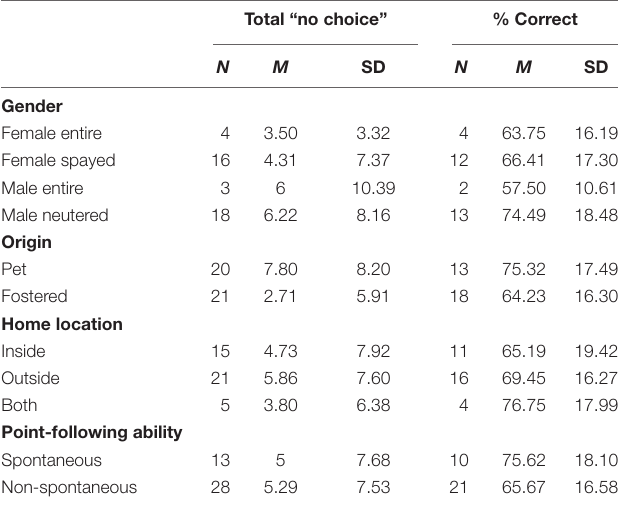
N = sample size, M = mean, SD = standard deviation.